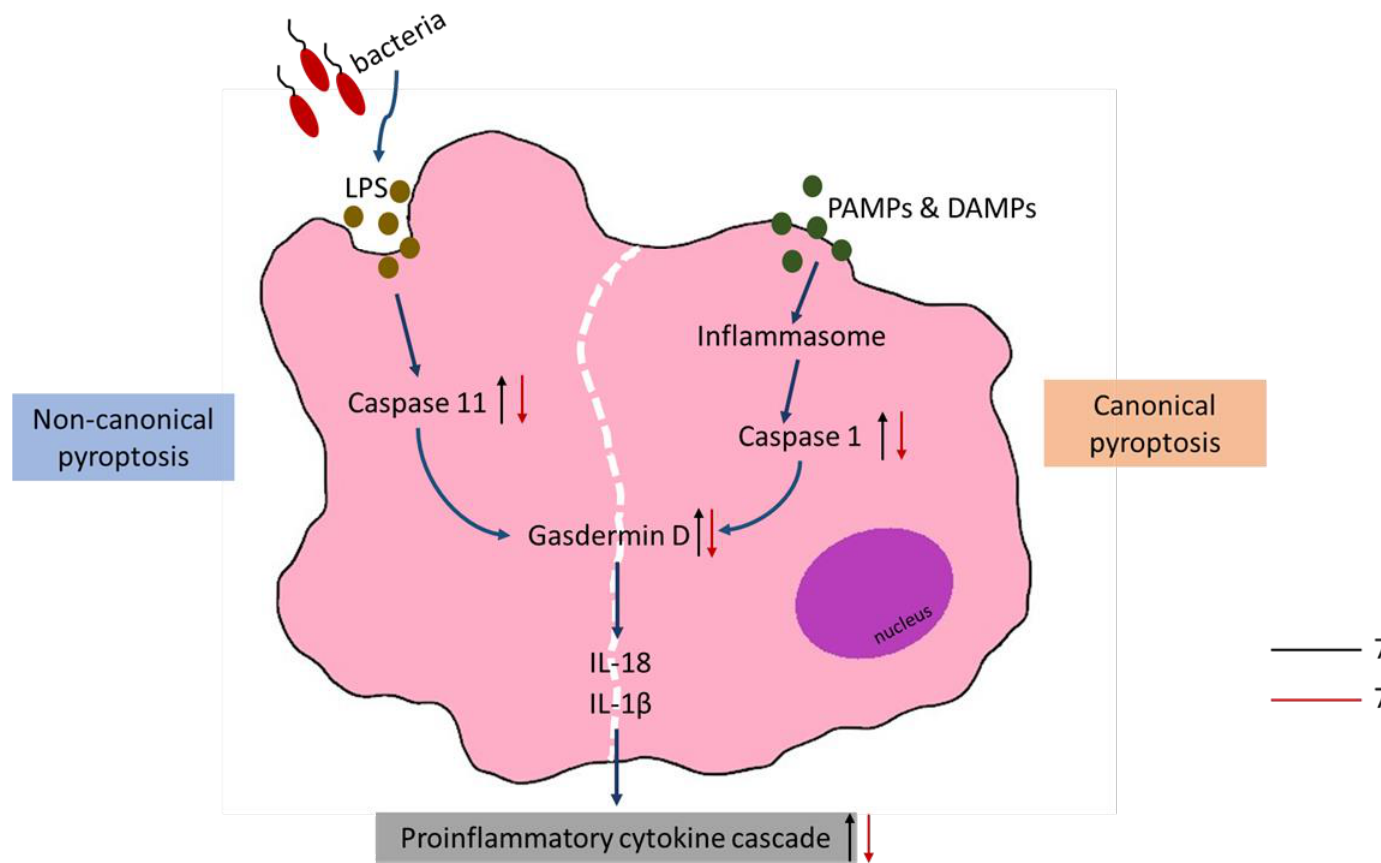
Figure 6. A schematic diagram illustrating the effects of dietary glutamine supplementation on liver pyroptosis in mice with polymicrobial sepsis 72 h after cecal ligation and puncture. PAMPs, pathogen-associated molecule patterns; DAMP, damage-associated molecule patterns; LPS, lipopolysaccharide; IL-18, interleukin 18; IL-1 β , interleukin-1 β .